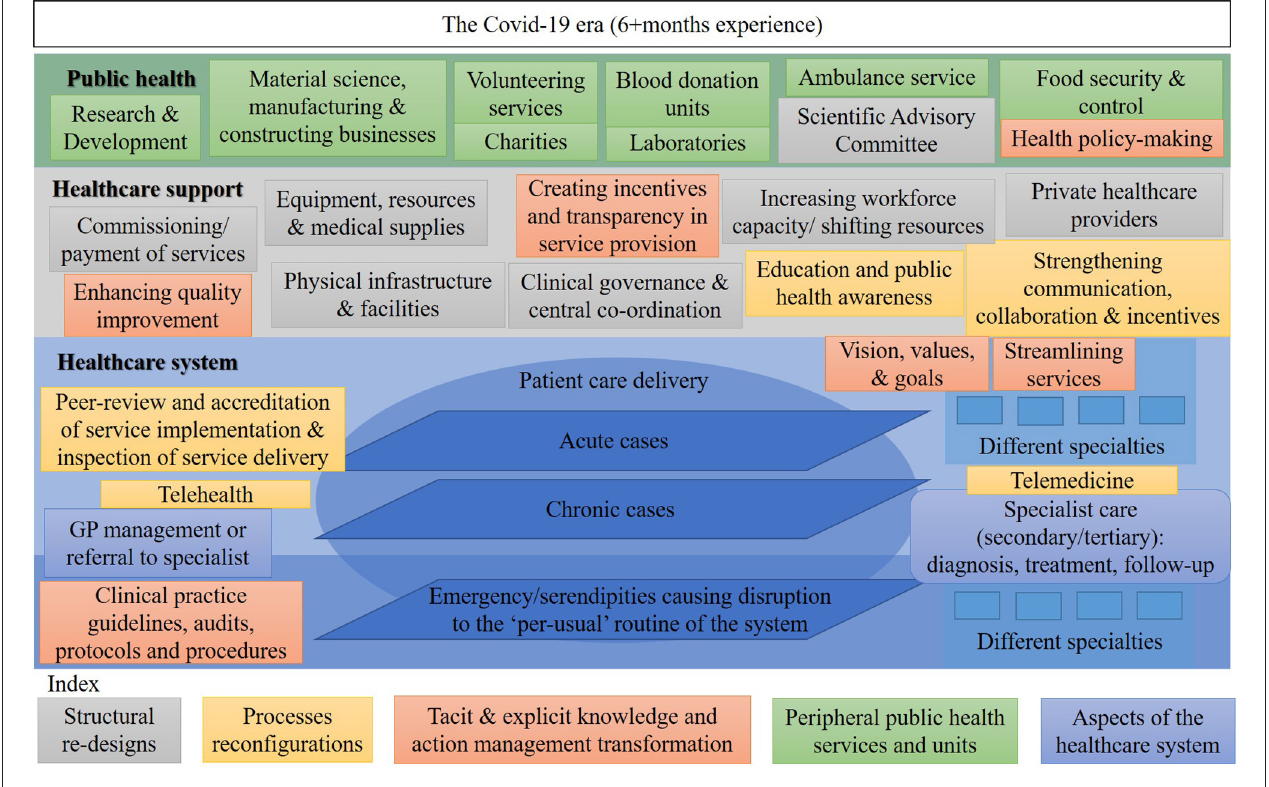
Frontiers in Public Health |